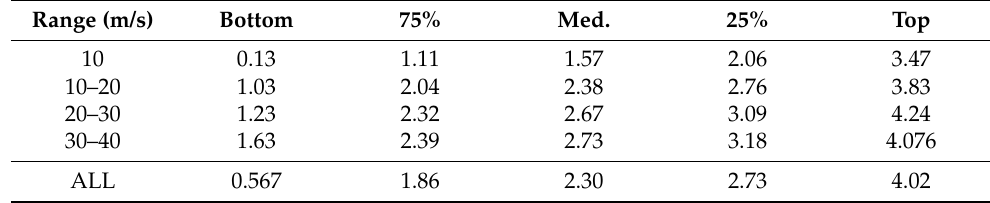
Table A1. Distribution of maximum acceleration (300 random vehicles, free acceleration). Range